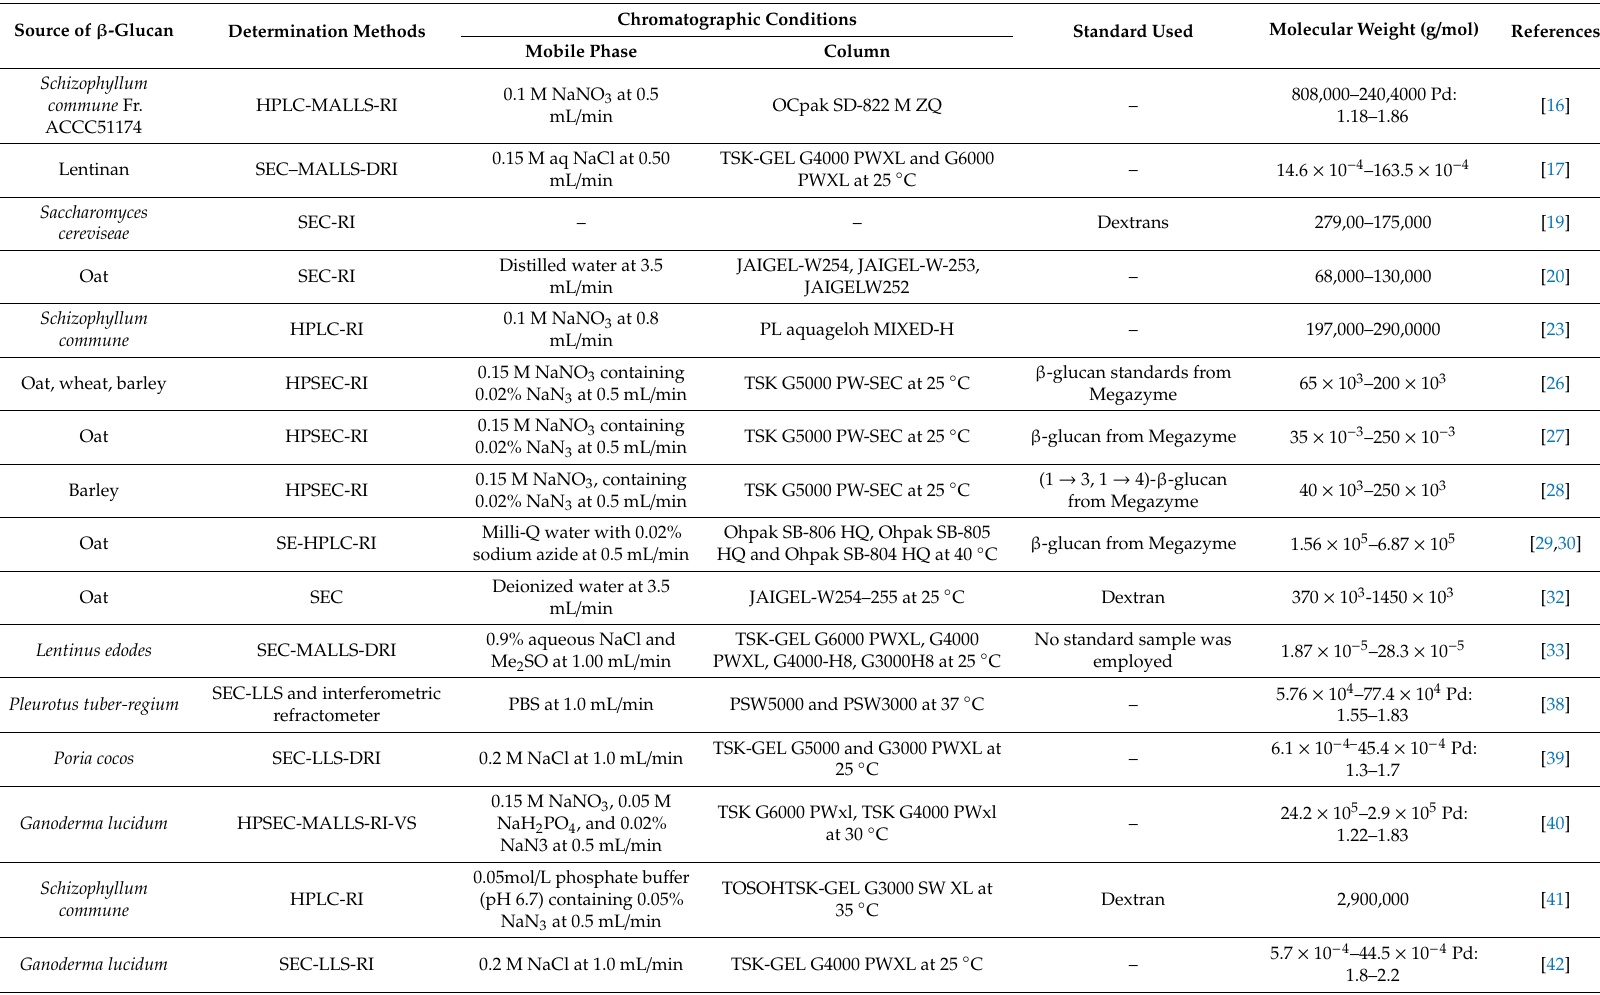
Table 1. Molecular weight of β -glucan extracted from various